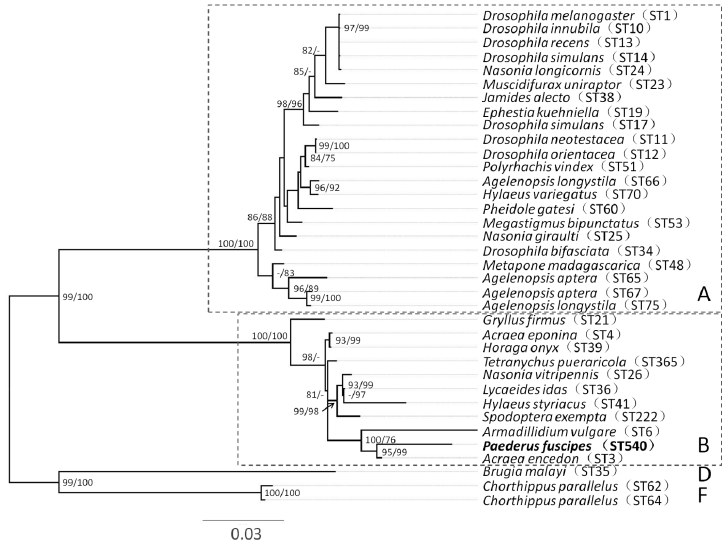
Figure 1. Maximum-likelihood phylogenetic tree of Wolbachia MLST sequences from P. fuscipes and additional ST sequences from a wide range of host species. The phylogeny is inferred by IQTREE. Numbers beside nodes are IQTREE ultrafast bootstrap and SH-aLRT values. The affiliation to the respective supergroup ( A , B , D , F ) is indicated. The Wolbachia infection densities analyzed through qPCR with the specific wsp gene along with an endogenous control gene (RPS3) were found to vary significantly (F (3,32) = 16.023, p < 0.01) across the developmental stages. The infection density in adults was significantly higher than in any other life stage (Figure 2). Moreover, the Wolbachia infection density significantly varied between host body parts and tissues, both in females (F (4,40) = 79.783, p < 0.01; Figure 3) and males (F (4,40) = 68.353, p < 0.01; Figure 3), with significantly high infection densities in reproductive tissues and lower densities in the gut (Figure 3). However, the relative Wolbachia densities between females and males for body parts and tissues were not significantly different. The densities of Wolbachia are therefore substantially influenced by developmental stage and tissues, but not gender.